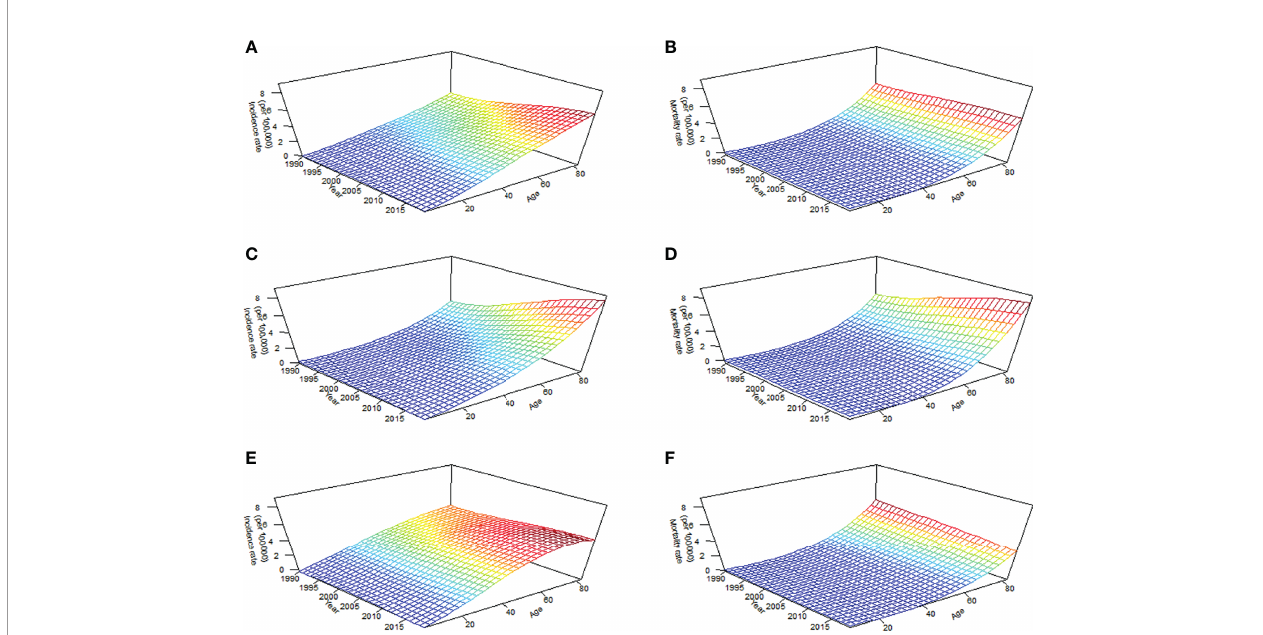
FIGURE 1 | Long-term trends in crude incidence and mortality rate of thyroid cancer by age from 1990 to 2019 in China: incidence (A) and mortality (B) in total population; incidence (C) and mortality (D) in men; incidence (E) and mortality (F) in